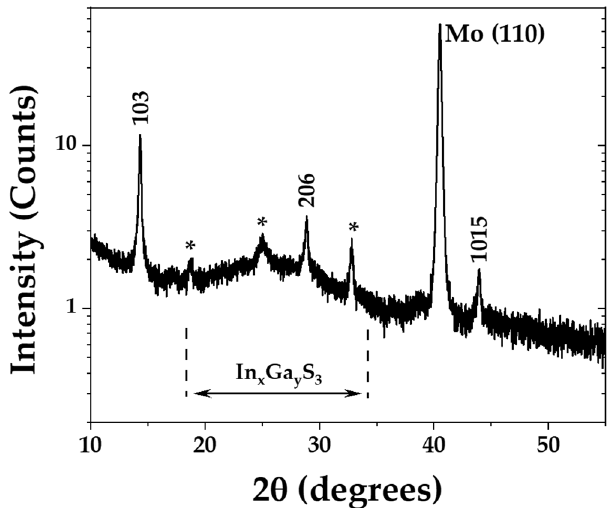
Fig. 3. X-ray diffraction pattern measured from layer at the end of the fi rst stage. The indexed peaks correspond to re fl ections assigned to b -In 2 S 3 structure. The peaks pointed by stars, as well as the broad signal ranging between 18 ° and 34 ° , is assigned to In x Ga y S 3 hexagonal/rhombohedral